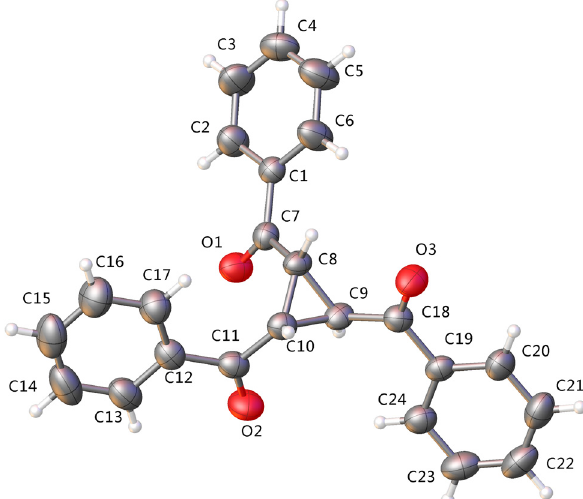
Table  : Data collection and handling.